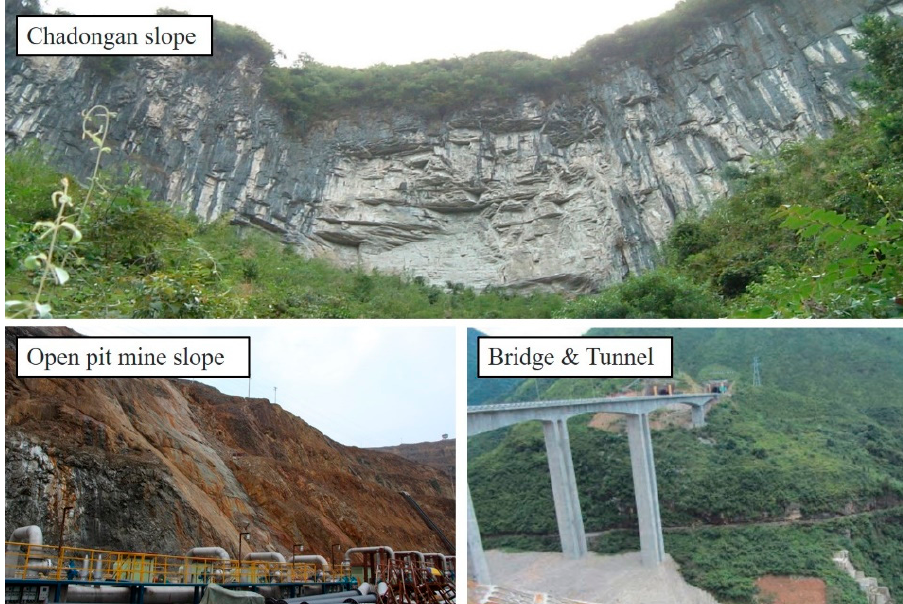
Figure 1. Common rock engineering.